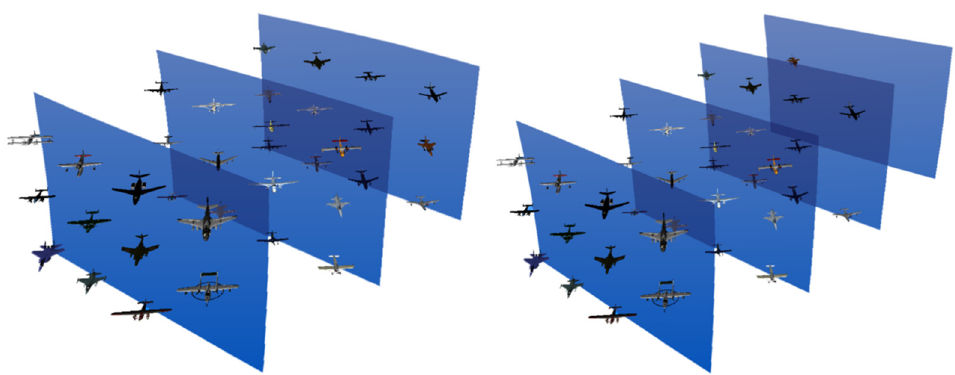
Figure 14. Experimental diagram of the information layers.